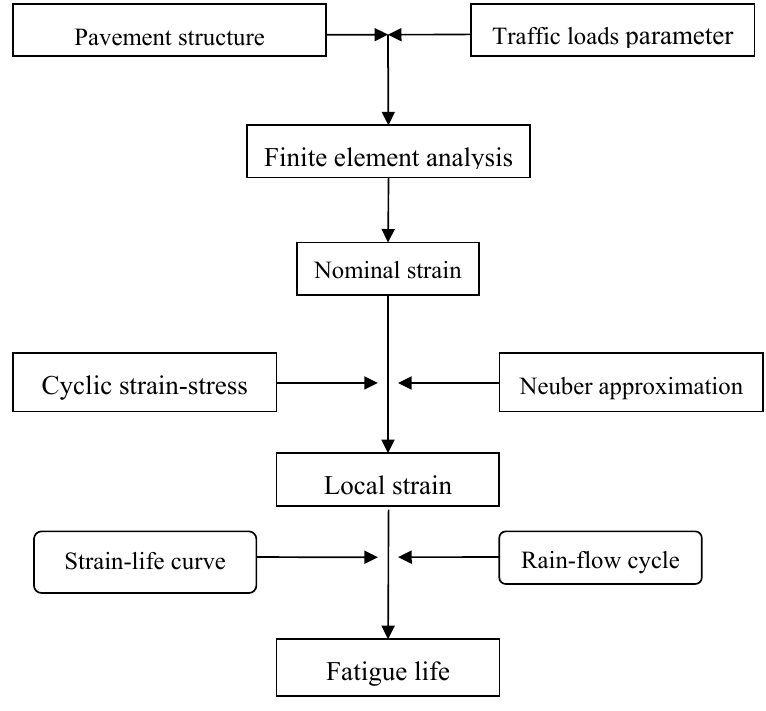
Figure 1. Process for fatigue life estimation based on local stress-strain method.